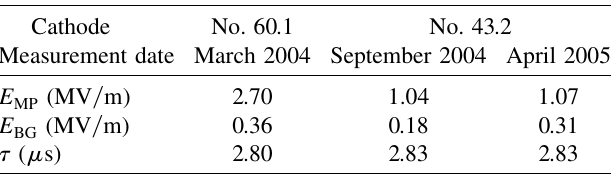
TABLE I. Fit results for the multipacting measurements in Fig. 9. ) between the rear